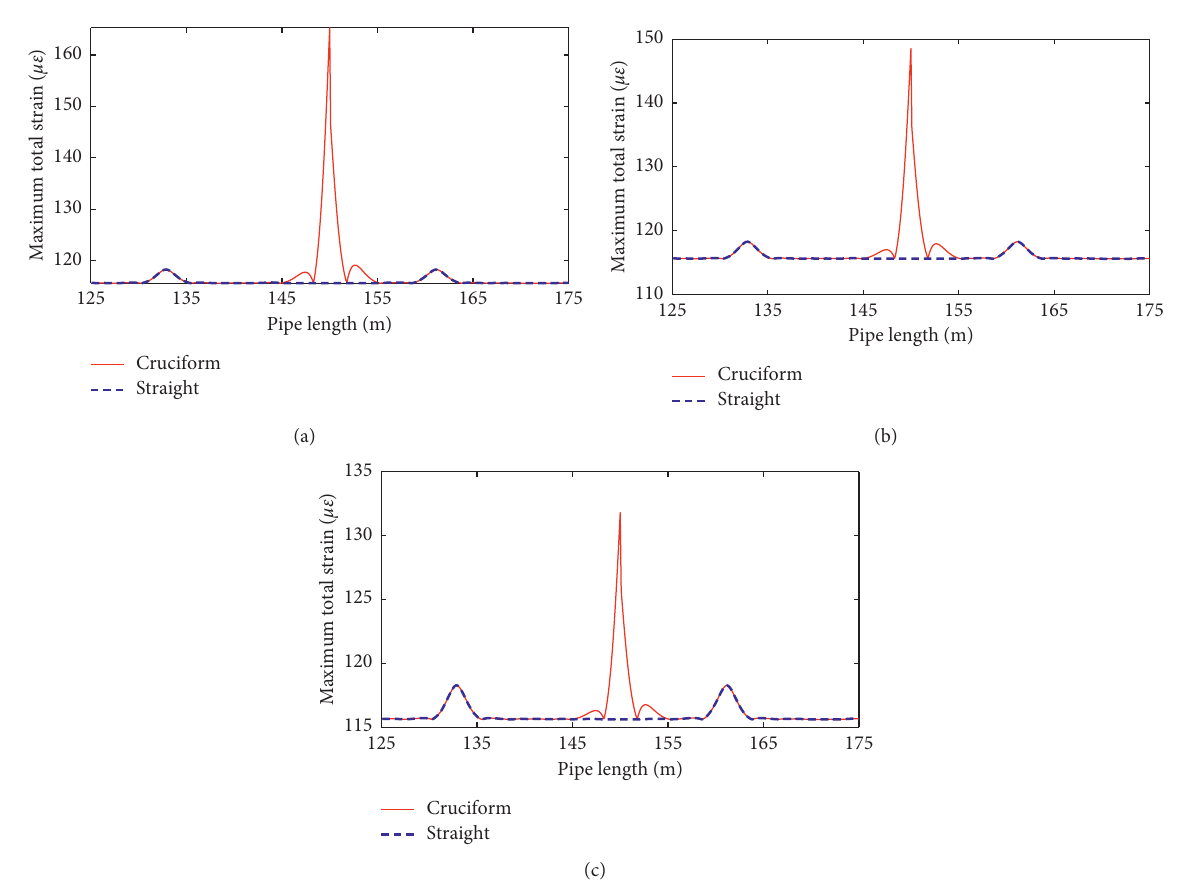
Figure 16: Different branch angles of cruciform connection.